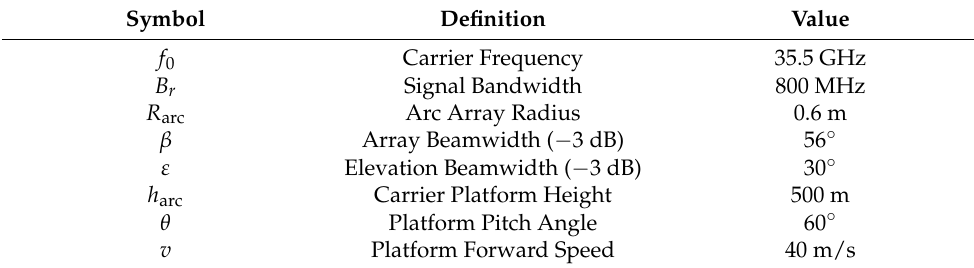
Table 1. Parameters of arc array SAR